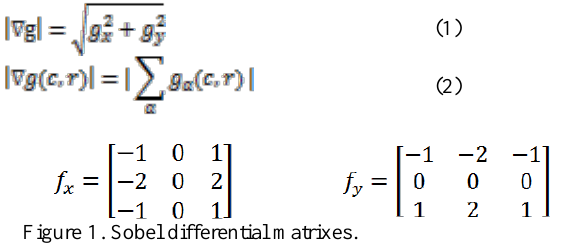
Figure 1. Sobel differential